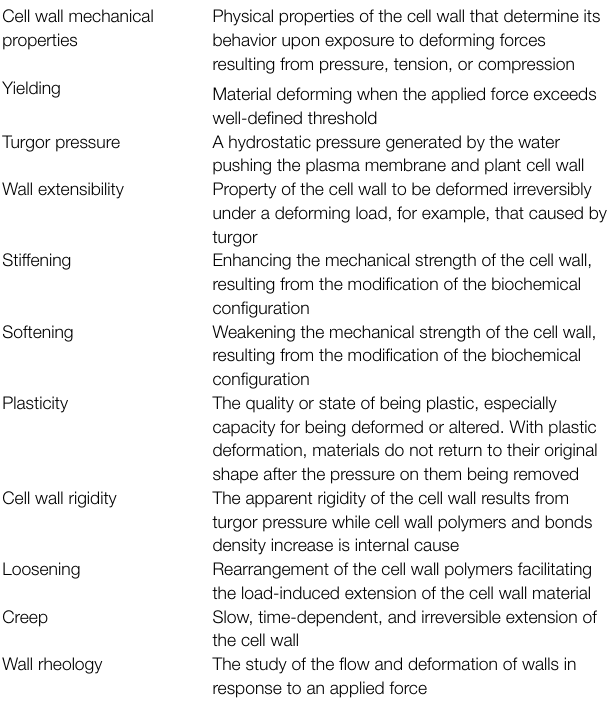
TABLE 1 | Glossary of the terms for cell wall mechanics often used in the context of plant morphogenesis. Cell wall mechanical